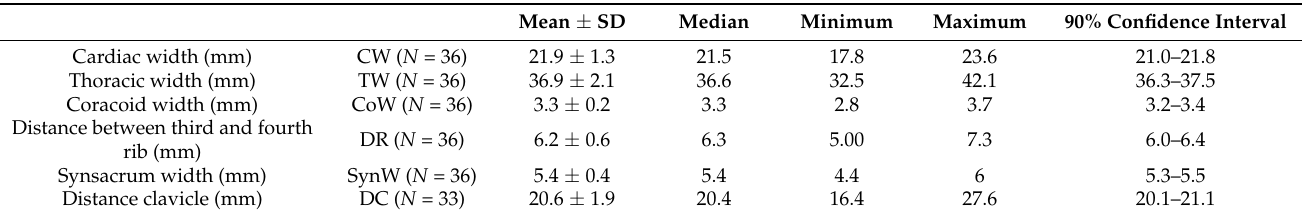
Table 1. Measurements from the VD radiographic projection. The mean value with standard deviation, minimum, maximum, and confidence intervals of the variables are reported.